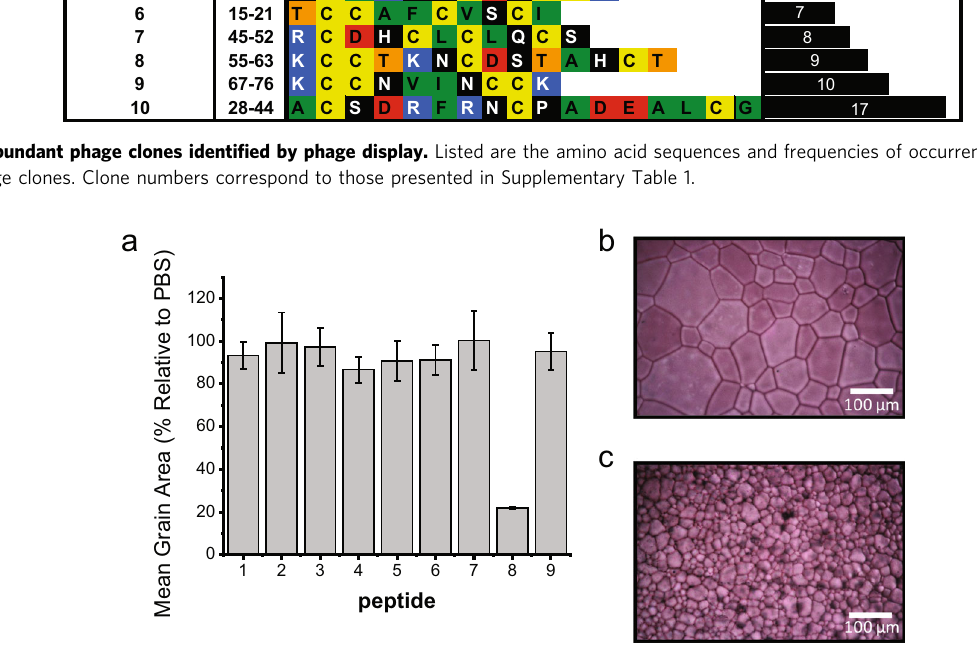
and their respective HPLC and LC – MS data can be found in Supplementary Figs. 2 – 10.